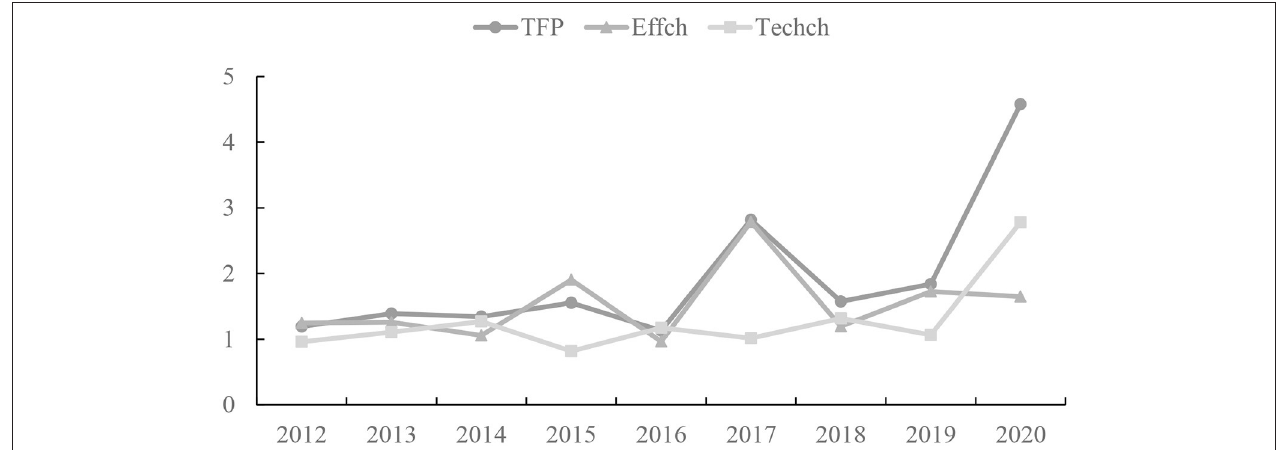
FIGURE 2 | The annual change trend of total factor productivity (TFP), technical efficiency change (EFFCH), and technological progress change (TECHCH) of 17 sample enterprises in the food industry from 2011 to 2020.